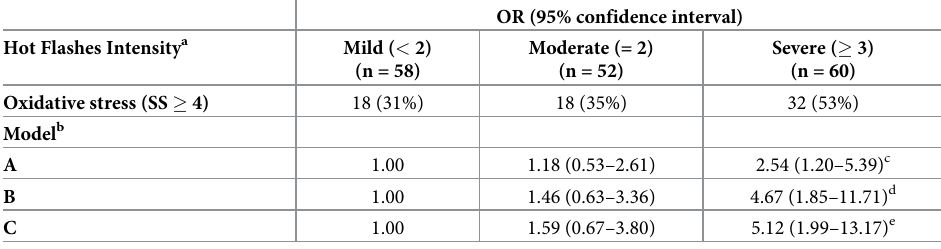
OR (95% confidence interval)